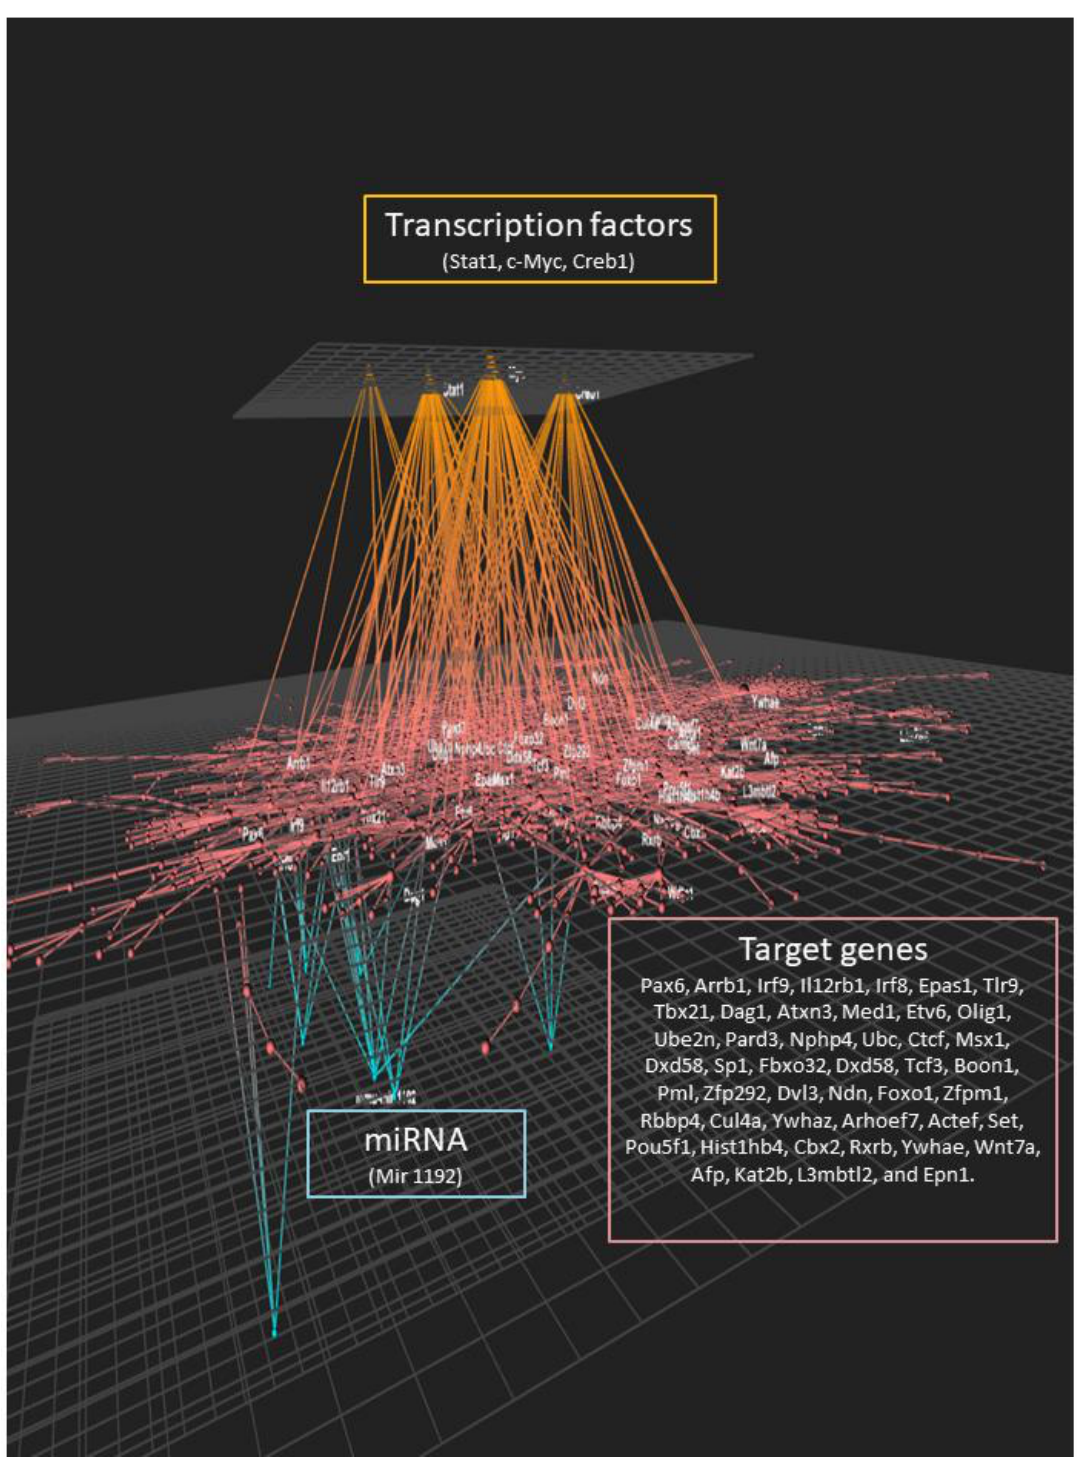
Figure 6. Protein–protein network enriched with transcription factors and miRNA regulation. Protein–protein interactions were identified using the STRING database from differentially expressed genes. Interactions between the protein–protein network, differentially expressed miRNAs (Mir 1192), and potential transcription factors (Stat1, c-Myc, Creb1) were constructed using the OmicsNet online tool. Target genes are: Pax6, Arrb1, Irf9, Il12rb1, Irf8, Epas1, Tlr9, Tbx21, Dag1, Atxn3, Med1, Etv6, Olig1, Ube2n, Pard3, Nphp4, Ubc, Ctcf, Msx1, Dxd58, Sp1, Fbxo32, Dxd58, Tcf3, Boon1, Pml, Zfp292, Dvl3, Ndn, Foxo1, Zfpm1, Rbbp4, Cul4a, Ywhaz, Arhoef7, Actef, Set, Pou5f1, Hist1hb4, Cbx2, Rxrb, Ywhae, Wnt7a, Afp, Kat2b, L3mbtl2, and Epn1.